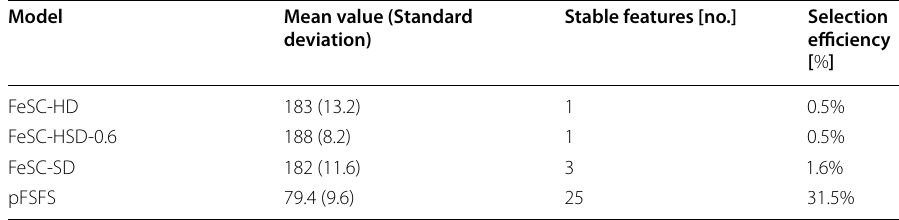
Table 4 Selected and stable features in the SS dataset Model